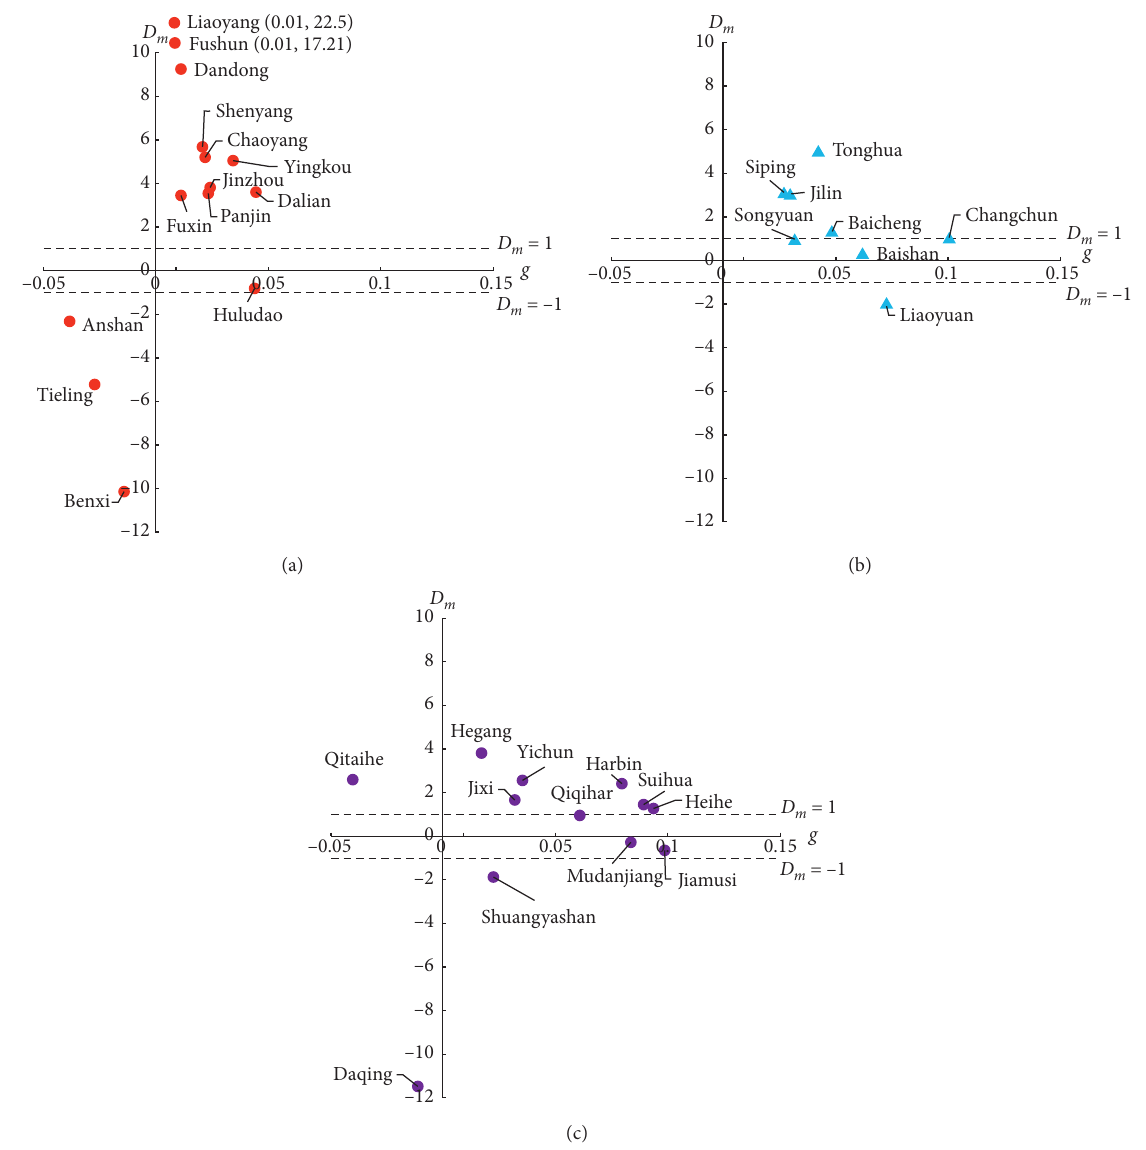
Figure 11: Decoupling chart of the material consumption of infrastructure construction for 34 cities in Northeast China during 2010–2017 ( D m ). (a) shows the decoupling of the material consumption of infrastructure construction in 14 cities of Liaoning province. (b) shows the decoupling of material consumption of infrastructure construction in eight cities in Jilin province. (c) shows the decoupling of the material consumption of infrastructure construction in 12 cities of Heilongjiang province. D m � the decoupling indicator for the material con- sumption of infrastructure; g � geometric average of the growth rate of gross domestic product (GDP) in a certain